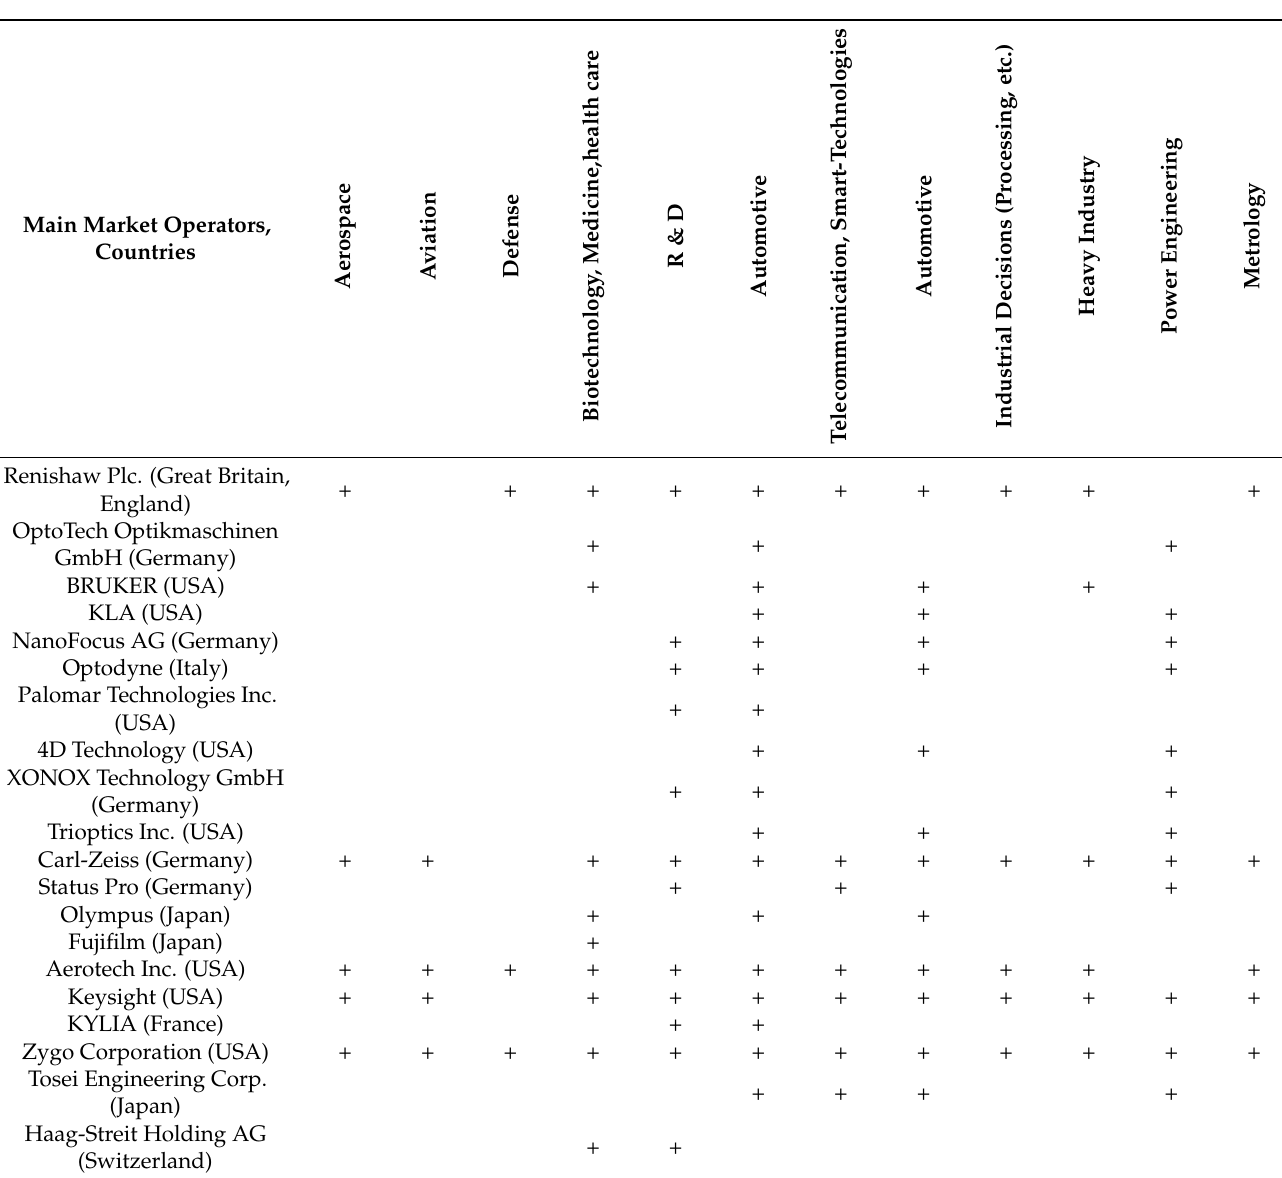
Table 2. Functional segments of interferometers and their coverage by the existing market operators, 2021 1